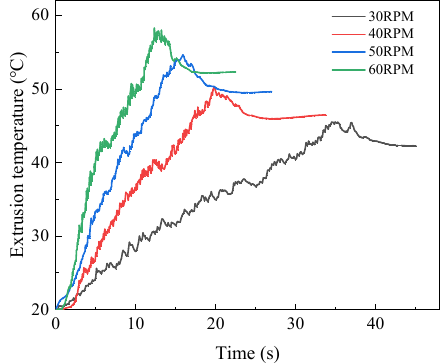
Figure 20. Influence of machine tool speed on